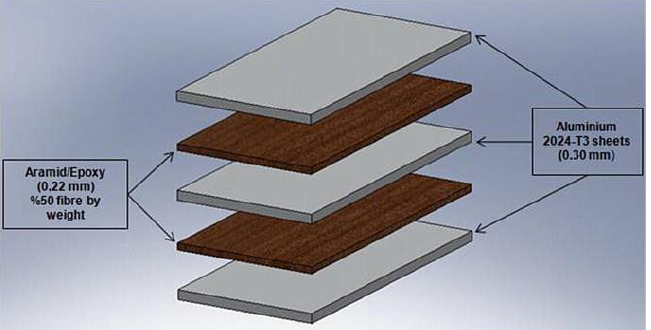
Figure 11. Schematic presentation of ARALL fibre metal laminates (adapted with permission from Ref. [90], Copyright 2011 Elsevier Ltd.).